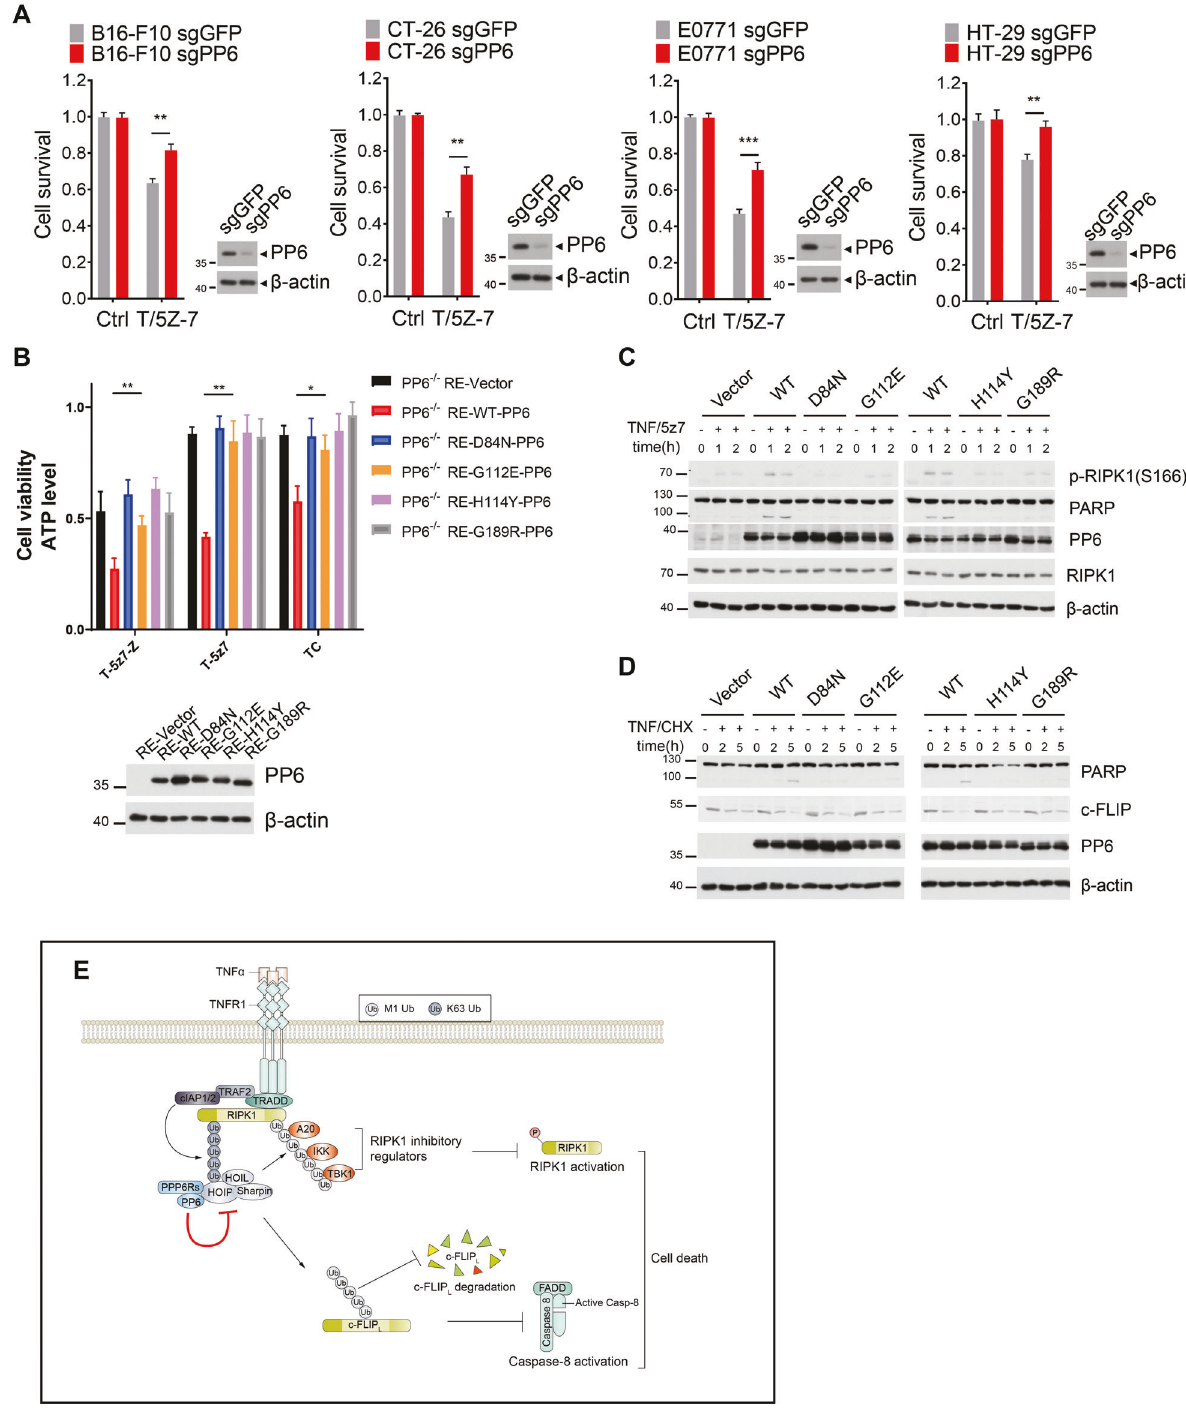
Fig. 7 Melanoma-associated PP6 inactivating mutations reduce the sensitivity to TNF α . A PP6 was removed by speci fi c sgRNA in B16-F10 (murine melanoma cell), CT-26 (murine colorectal carcinoma cells), E0771 (murine breast adenocarcinoma cells) and HT-29 (human colorectal adenocarcinoma cell) tumor cells. Cells were then treated with TNF α /5Z-7 for 6 h. B PP6 − / − MEFs were reconstituted with control vector, WT- PP6, D84N-PP6, or melanoma-associated G112E-PP6, H114Y-PP6, and G189R-PP6. Cells were then treated with TNF α /zVAD/5Z-7 and TNF α /5Z-7 for 4 h or TNF α /CHX for 10 h. The panel on the right showed the ef fi ciency of PP6 reconstitution. C , D Control vector, WT-PP6, D84N-PP6, or melanoma-associated G112E-PP6, H114Y-PP6, and G189R-PP6 reconstituted PP6 − / − MEFs were treated with TNF α /5Z-7 or TNF α /CHX for indicated periods of time. Cells were lysed with RIPA buffer and analyzed by western blotting with indicated antibodies. E A schematic model shows that PP6 negatively modulates LUBAC-mediated M1-ubiquitination of RIPK1 and c-FLIP L to promote TNF α -mediated cell death. Concentrations of reagents used: TNF α (T), 50 ng/ml; CHX (C), 2 μ g/ml; zVAD (Z), 50 μ M; 5Z-7, 300 nM. The cell death in ( A , B ) was measured by CellTiter-Glo assay. Data represent mean ± SD of three independent experiments (Student ’ s t test * P < 0.05; ** P < 0.01; *** P < 0.001).